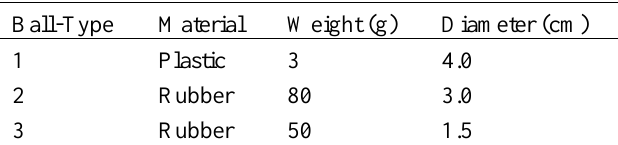
Photovoltaic input